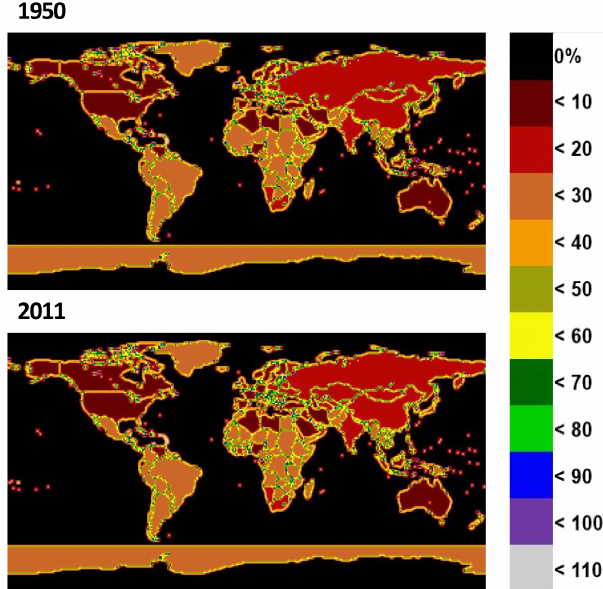
Figure 10. Two-component 2 σ uncertainty derived from FFCO2 tabular data and geography.